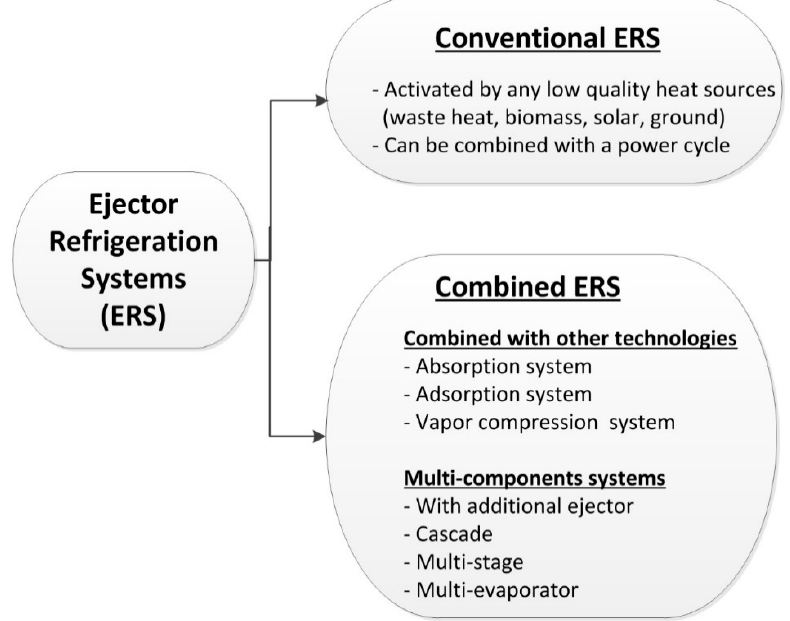
Figure 27. ERS classification. Figure 27. ERS